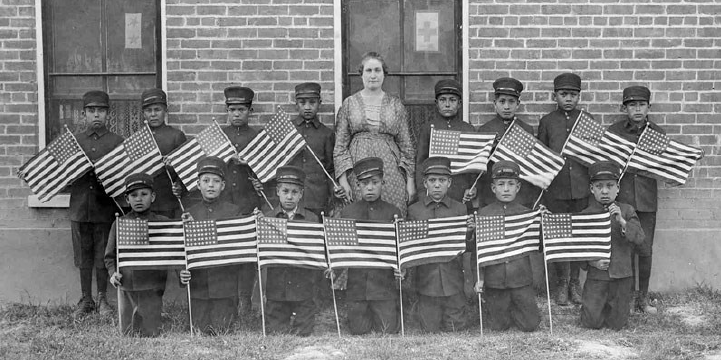
Figure 4. Albuquerque Indian School, ca. 1895. National Archives at Denver (NAID